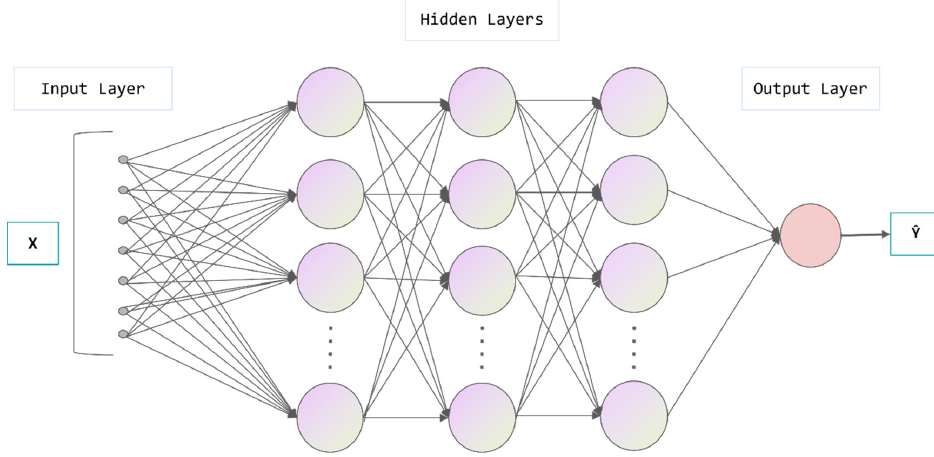
Figure 2. Deep neural network.